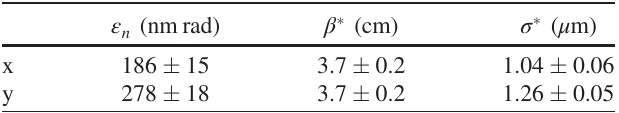
TABLE I. Normalized emittance ε n , Twiss β -function at the waist β (cid:2) , and corresponding beam size σ (cid:2) of the reconstructed transverse phase space